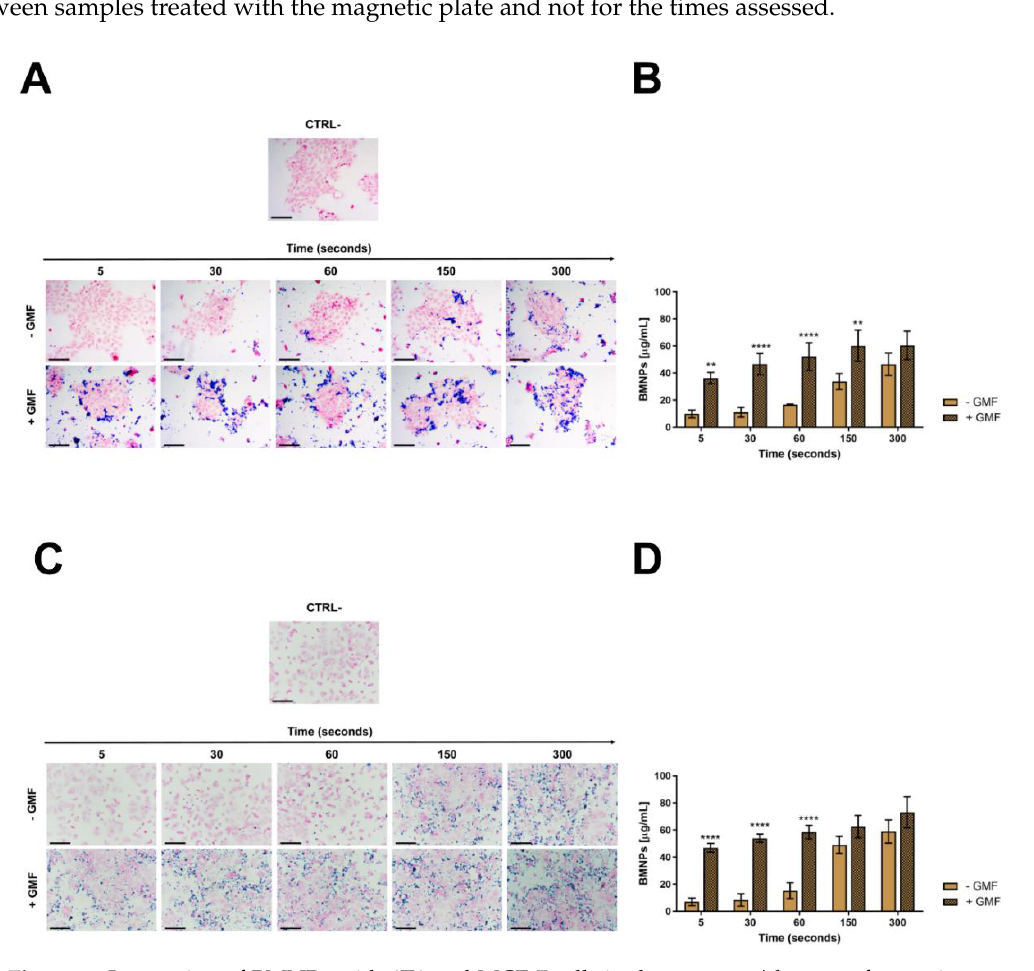
Figure 2. Interaction of BMNPs with 4T1 and MCF-7 cells in the presence/absence of a continuous gradient magnetic field: ( A , C ) Images showing BMNPs after Prussian blue staining and nuclear fast red counterstaining; scale bar: 50µm. ( B , D ) Graphs showing the amount of iron associated with the types of cells as quantified with potassium thiocyanate: Cells were incubated with BMNPs (100 µg/mL) for different times (from 5 to 300 s) in the absence (−GMF) and presence (+GMF) of a gradient magnetic field. Untreated cells were used as a negative control. The results (expressed as mean ± SD) were obtained in three independent experiments made in triplicates. Differences between groups were assessed by 2-way ANOVA with Sidak’s multiple comparison test. (**** p < 0.0001; ** p < 0.001).